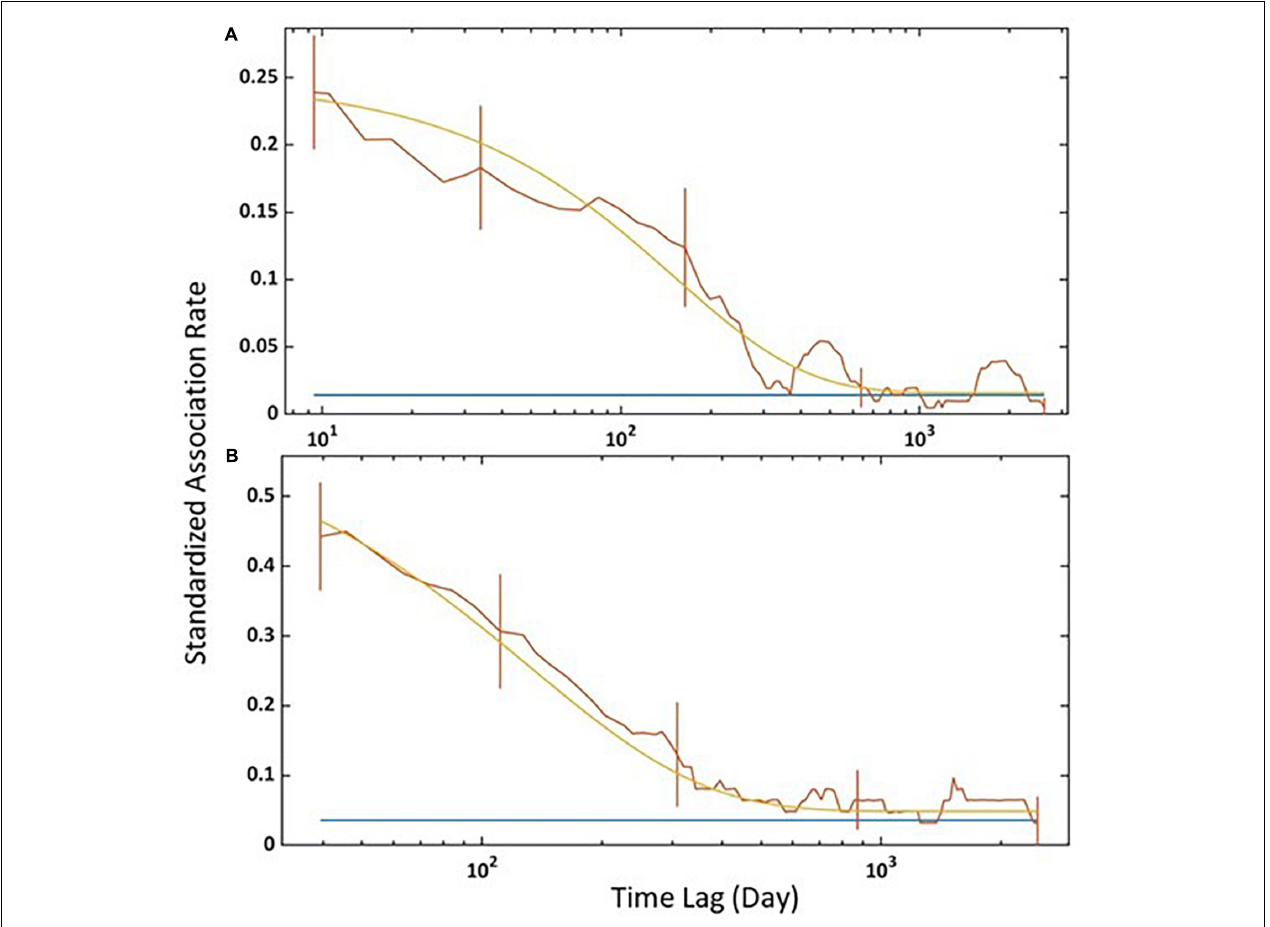
FIGURE 5 | Standardised lagged association rate (SLAR) for (A) all individuals and (B) adult females captured between 2011 and 2019. Vertical bars indicate SE calculated using the temporal jackknife method. The brown line is the observed data, the yellow line is the best-fitting model according to Table 5 , and the blue line is the standardised null association rate (i.e., if individuals associated